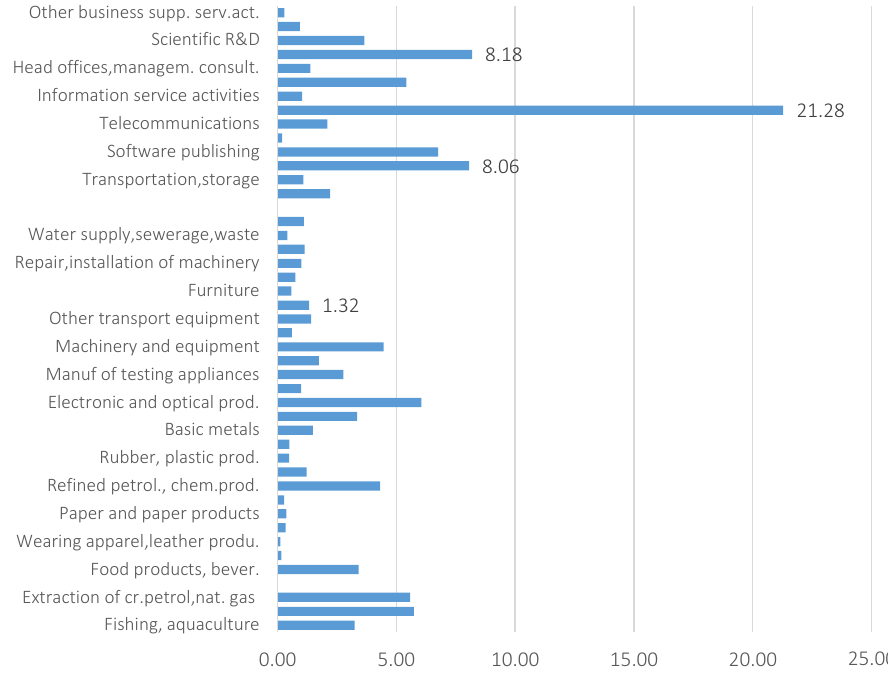
Figure 6. Structure of business enterprise R&D expenditure by industry,